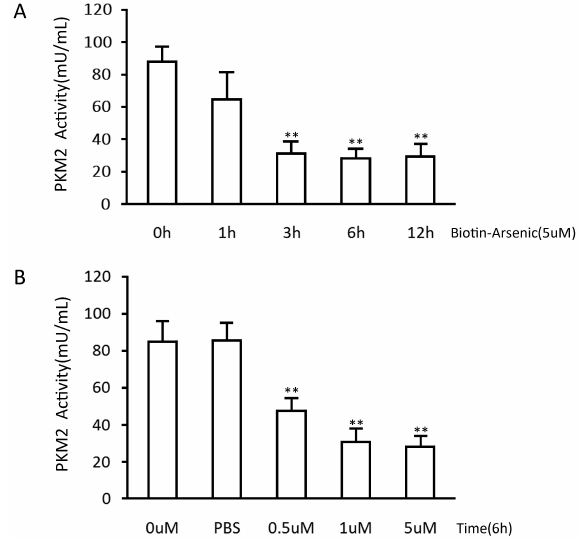
Figure 4. Arsenic-biotin suppresses PKM2 activity in NB4 cells. ( A ) Arsenic-biotin suppresses PKM2 activity in a time-dependent manner; ( B ) The changes in PKM2 activity in the cells treated with different concentrations of arsenic-biotin for 6 h. The PBS group was used as a negative control. The average of three measurements in separate experiments is shown with the SD;** p < 0.001.